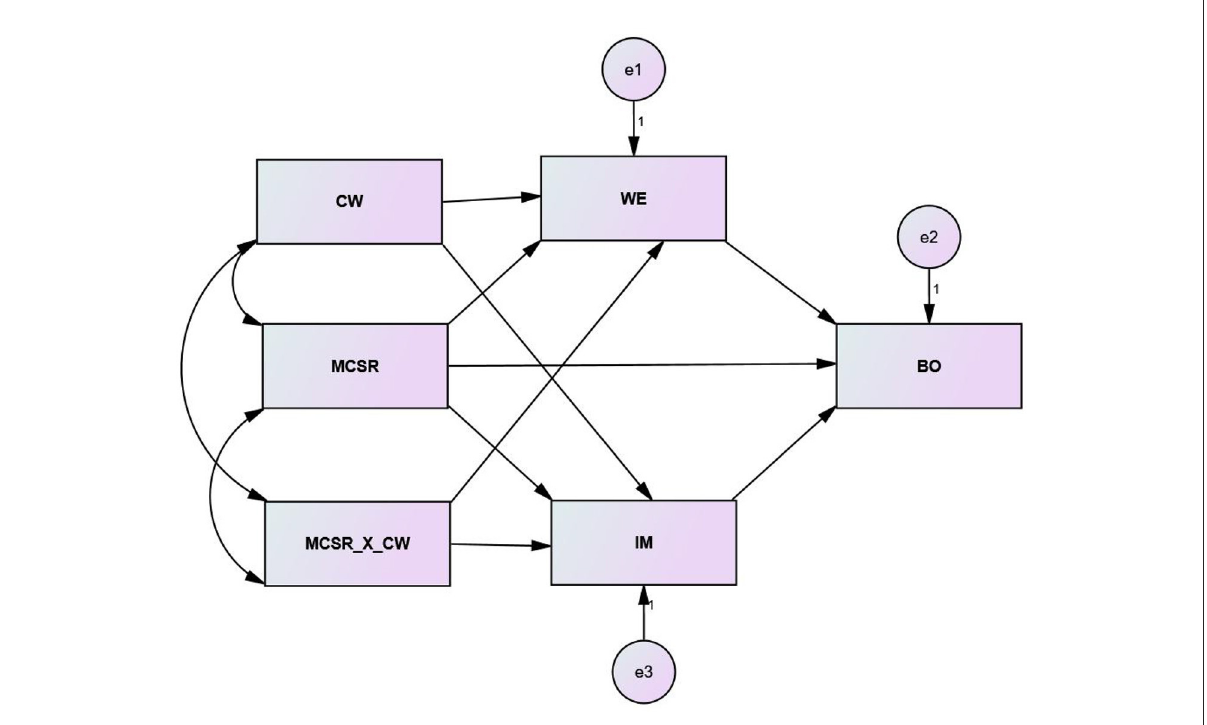
FIGURE1 The hypothesized structural